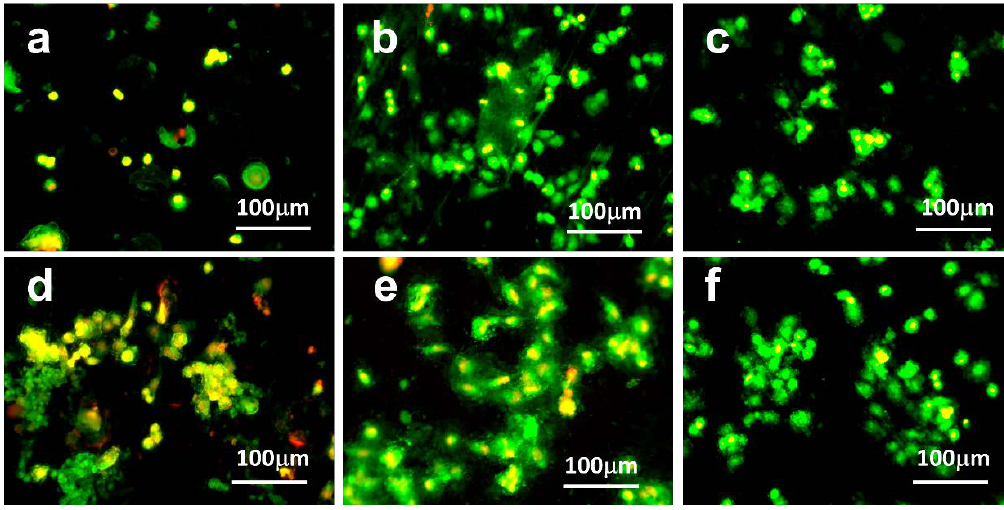
Figure 8. The typical fluorescent images of endothelial cells adhered on AZ31B ( a , d ), Mg–OH ( b , e ) and Mg–HF ( c , f ). The cells were cultured with samples for 6 h ( a – c ), 24 h ( d – f ), respectively. (yellow, nuclei; green, cytosketolon).